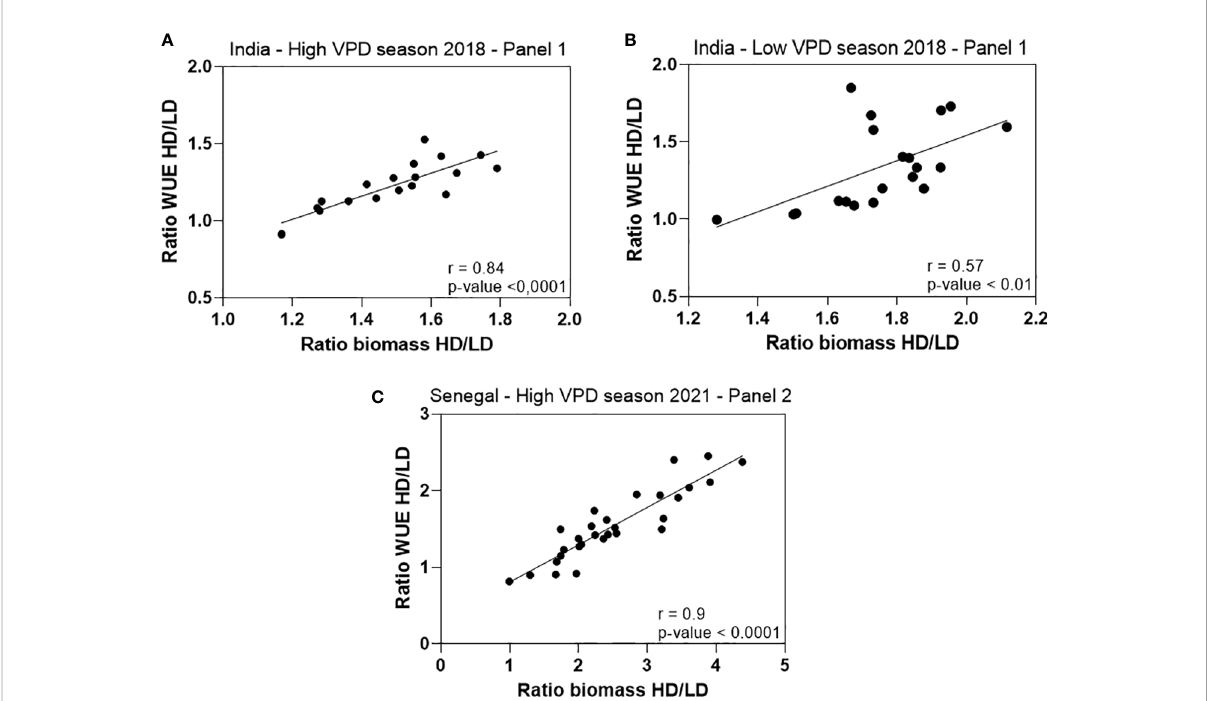
FIGURE 7 Correlation between the ratios of the WUE measured under high density to low density (WUE HD/WUE LD) as a function of the ratio of the biomass measured under high density to low density (Biomass HD/Biomass LD), using the data from the lysimeter trials carried out in India in 2018 and Senegal in 2021. Data shows positive and signi fi cant relation in both high VPD seasons in India (r = 0.84, p-value< 0.0001) (A) and Senegal (r = 0.9, p-value< 0.0001) (B) and also in the low VPD season in India (r = 0.57, p-value< 0.01) (C) . Ratios were calculated from the genotypic means of WUE and biomass in each of the density